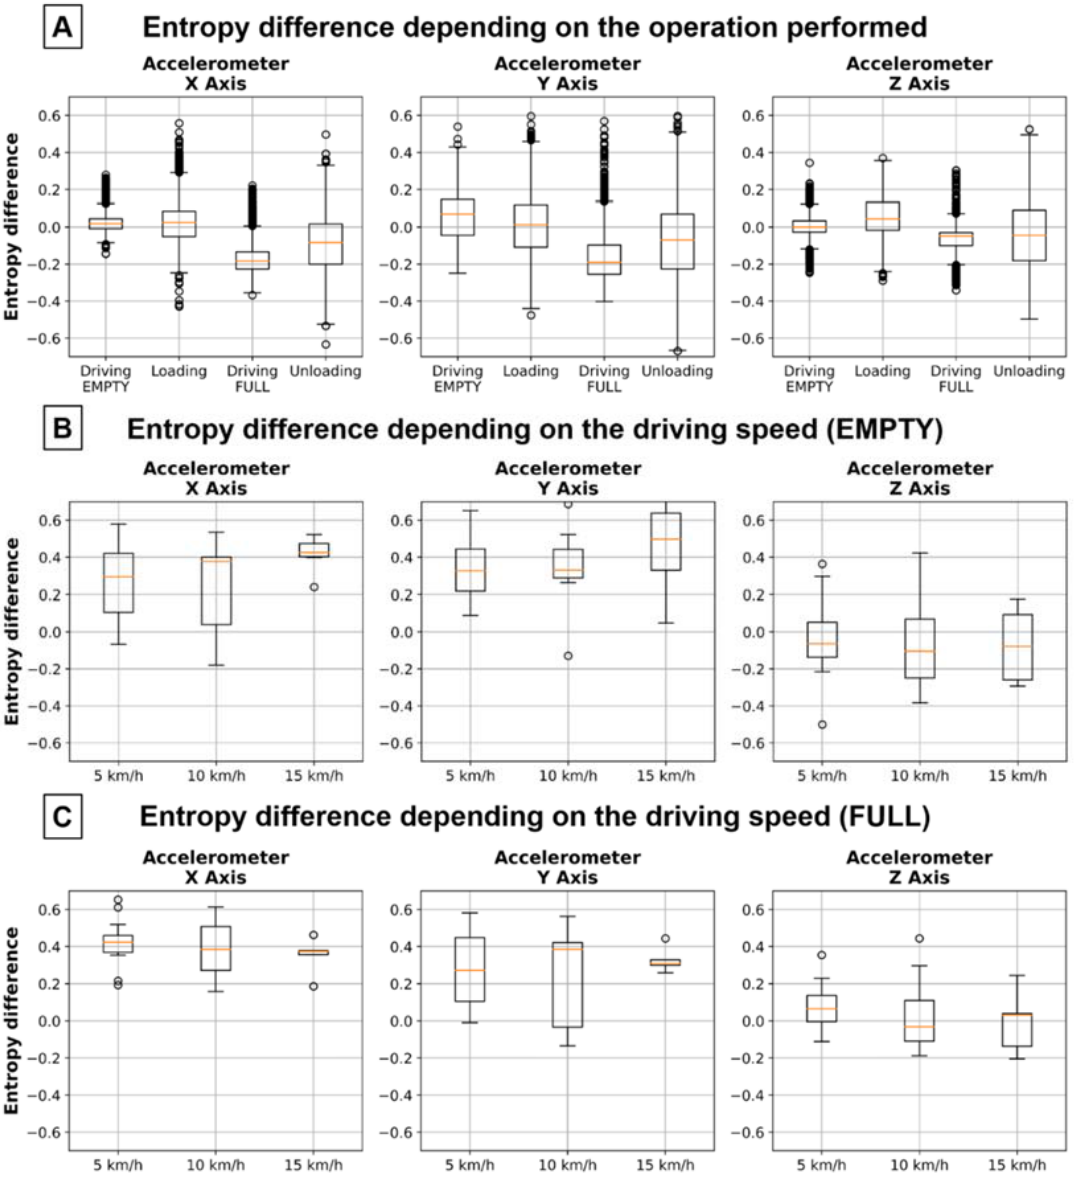
Figure 7. Comparison of the difference in entropy measured between the front and back, depending on the: A—operation performed, B—driving with different speeds with a full box, C—driving with different speeds with an empty box.